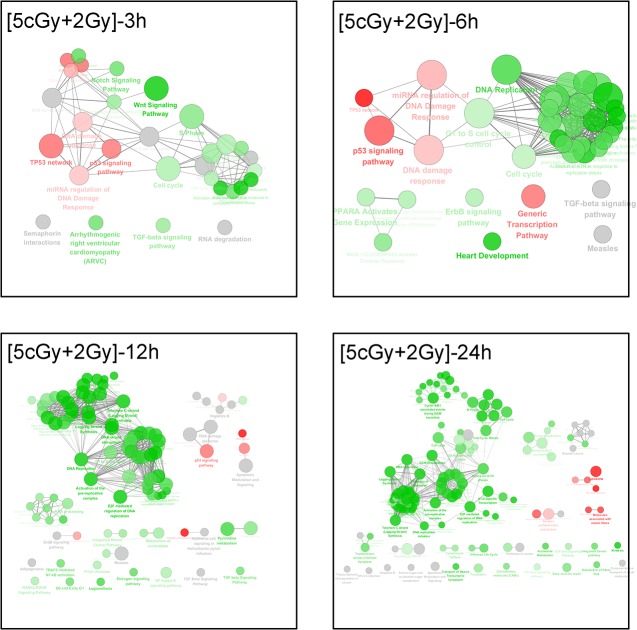
The pathway enrichment analysis results of the (5 cGy +2 Gy) group at different time points.The KEGG, REACTOME and WikiPathways databases in ClueGO were employed for pathway enrichment analysis of each differential group gene sets acquired from microarray analyses. The Enrichment/Depletion was tested by the two-side hypergeometric test, and the Benjamini and Hochberg false-discovery rate was set to 0.05. The green and red colors code for down-regulation and up-regulation of genes, respectively, in each group.